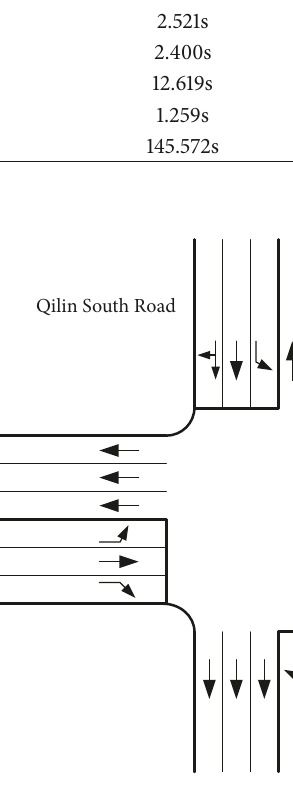
Figure 1: The layout of the survey